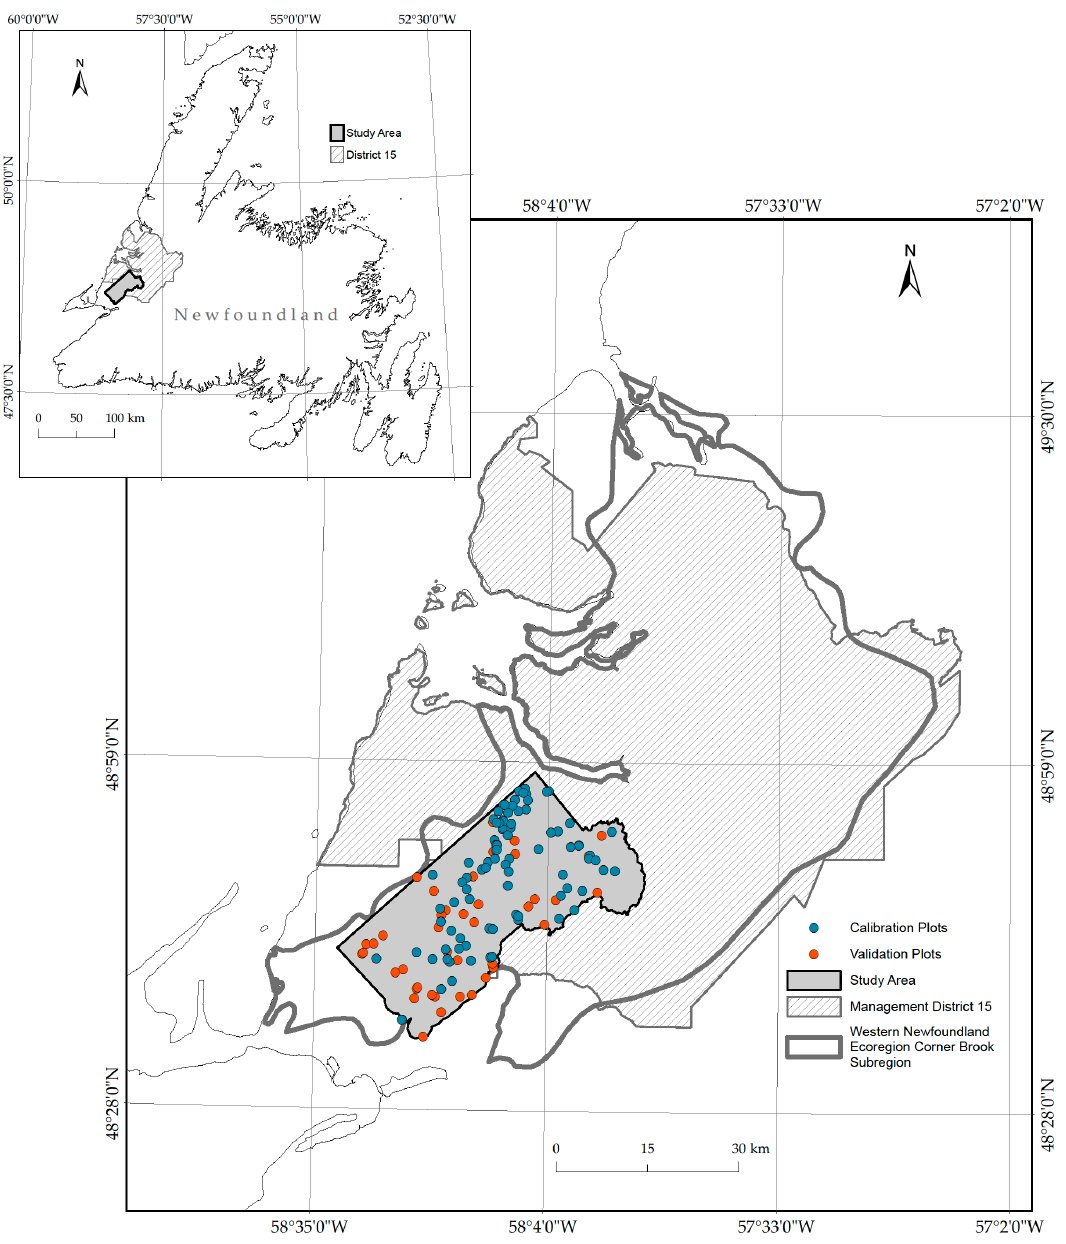
Figure 1. Spatial extent of the airborne laser scanner (ALS) study area with the extended area of Forest Management District 15 and the Corner Brook Subregion of the Western Newfoundland Ecoregion of Newfoundland, Canada.